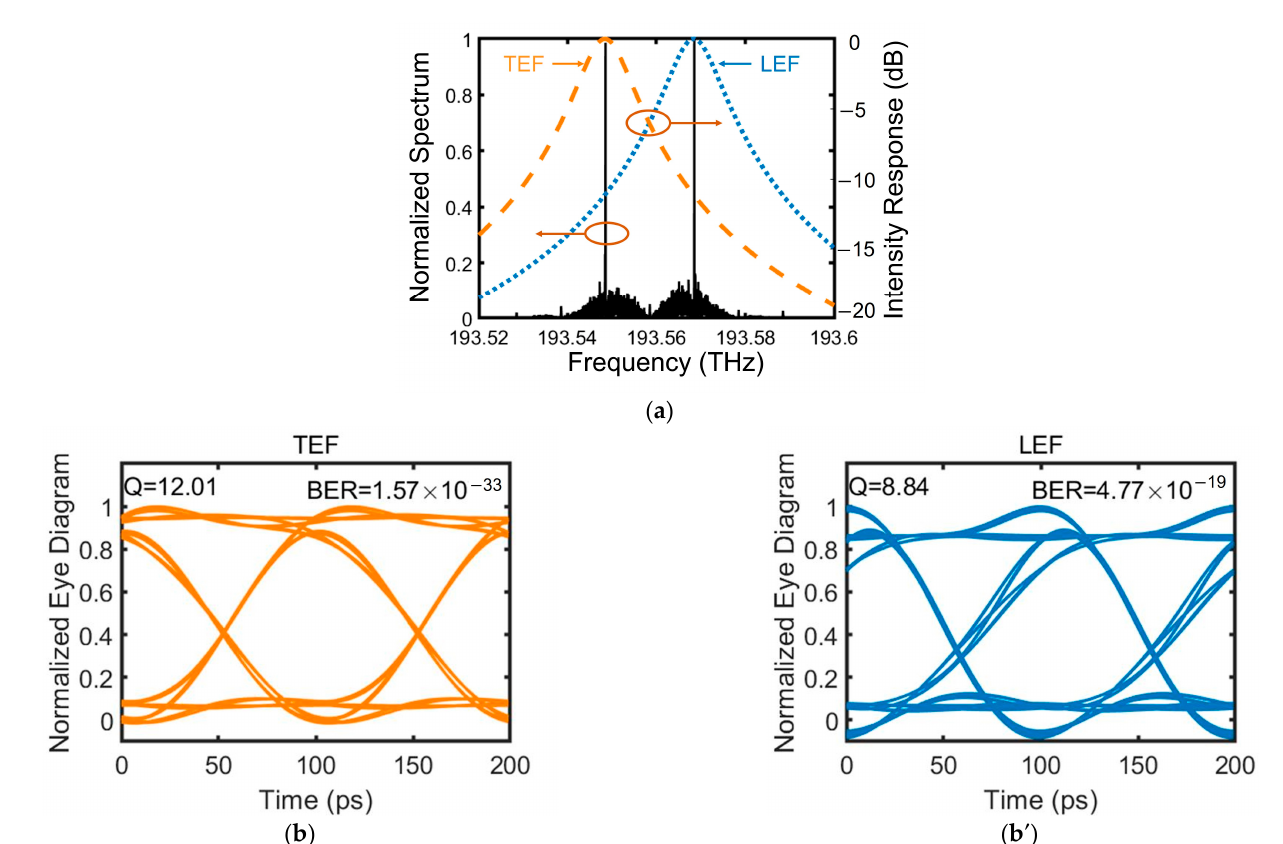
Figure 3. System performance comparison between the TEF and LEF: ( a ) the spectrum of the FM signal after 90 km optical fi ber transmission, and frequency responses of the TEF and LEF; ( b , b ′ ) the eye diagrams of the optical signal after slope filtering by the TEF and LEF, respectively, with the extracted effective SNR (Q) and bit error rate (BER) shown at the top of each